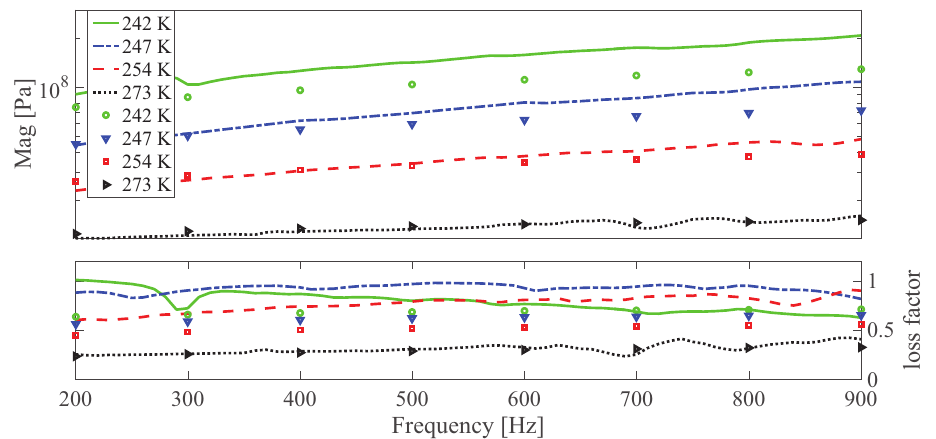
Figure 11. The magnitude and loss factor of the dynamic shear modulus versus frequency at 0.0005 strain amplitude and 0.55T magnetic field under different temperatures. Lines and symbols are the simulation and measurement results,